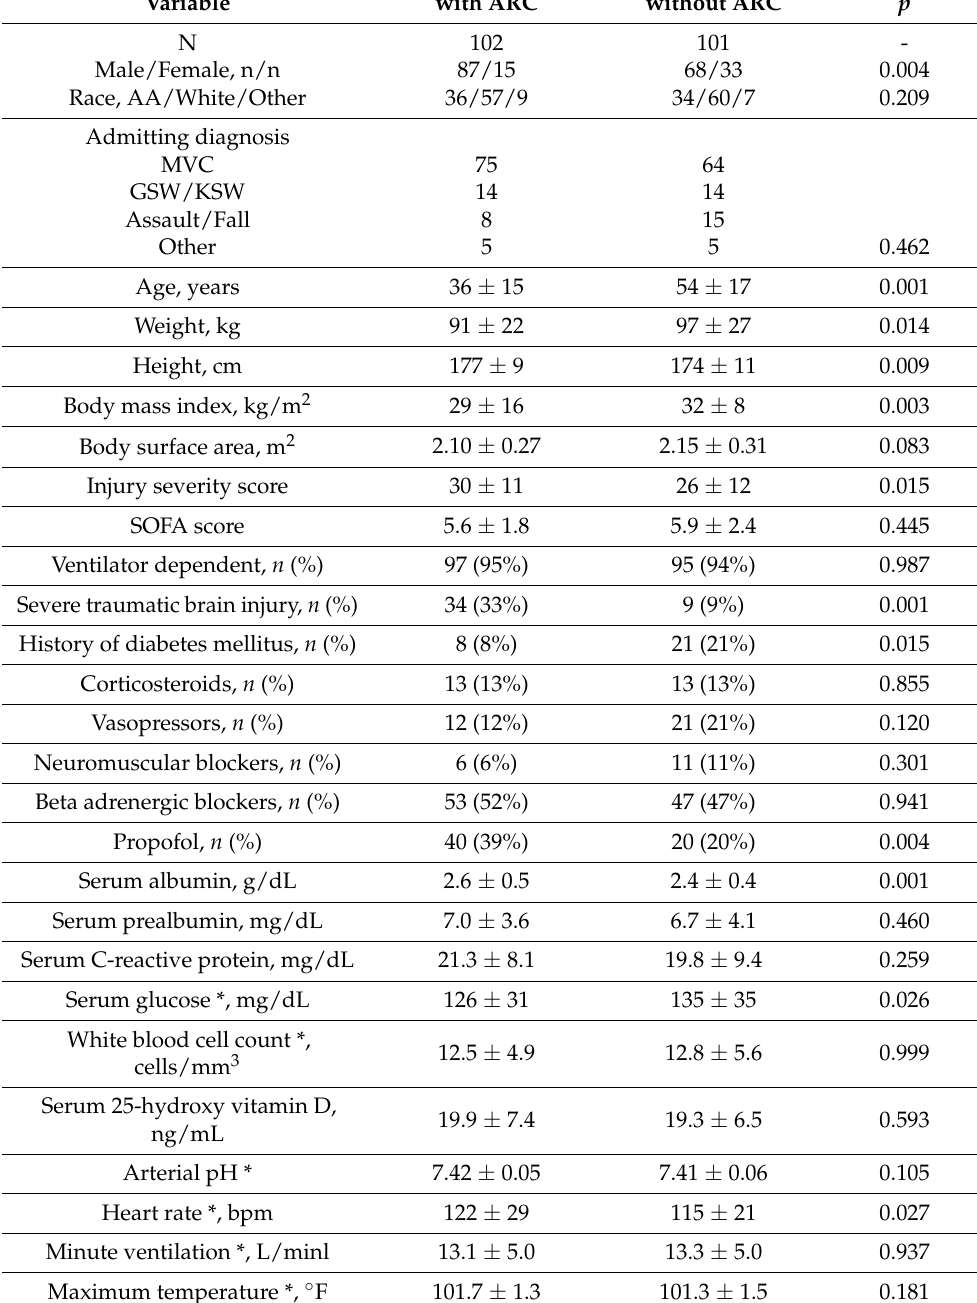
Table 1. Patient